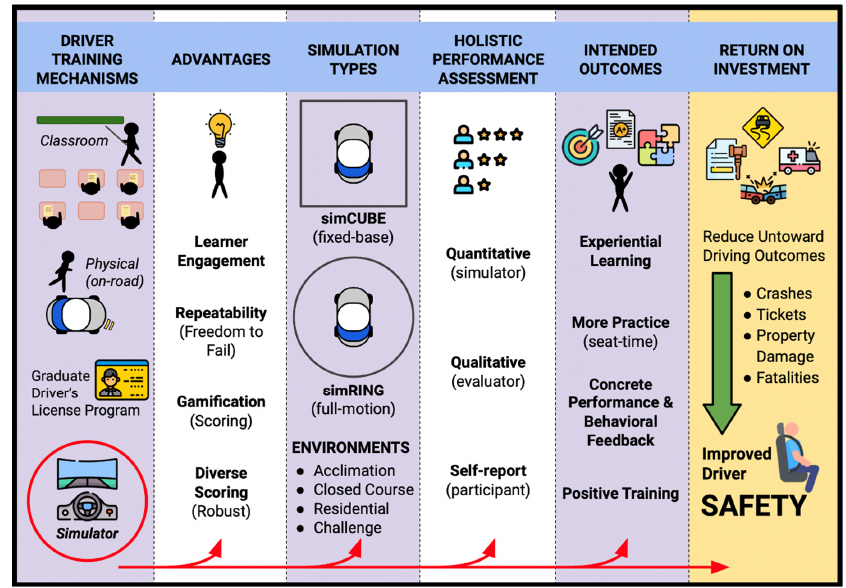
Figure 1. Teen driving framework—a blueprint theory of change (with